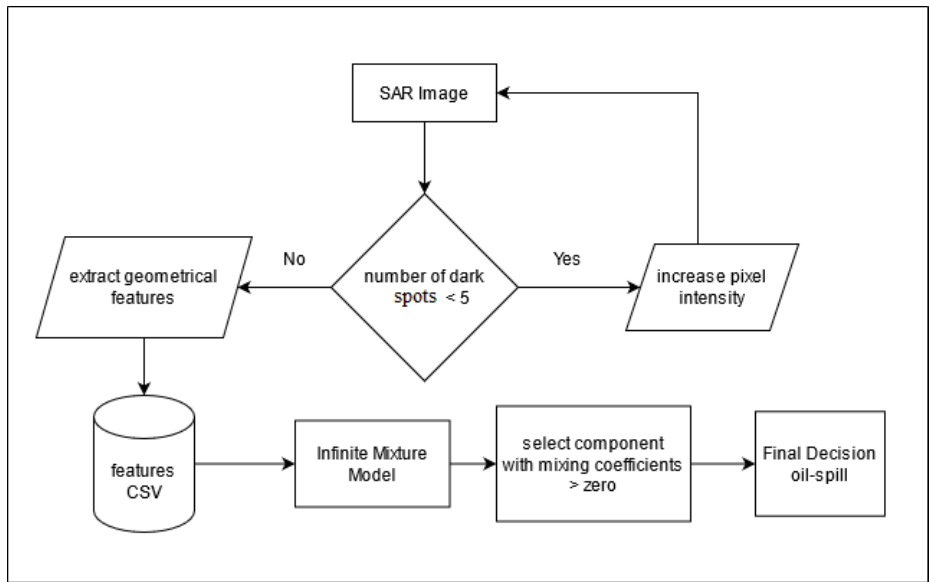
Figure 5. Flowchart diagram for extracting features using first feature extraction approach (ImageNet pretrained (resnet50) features).